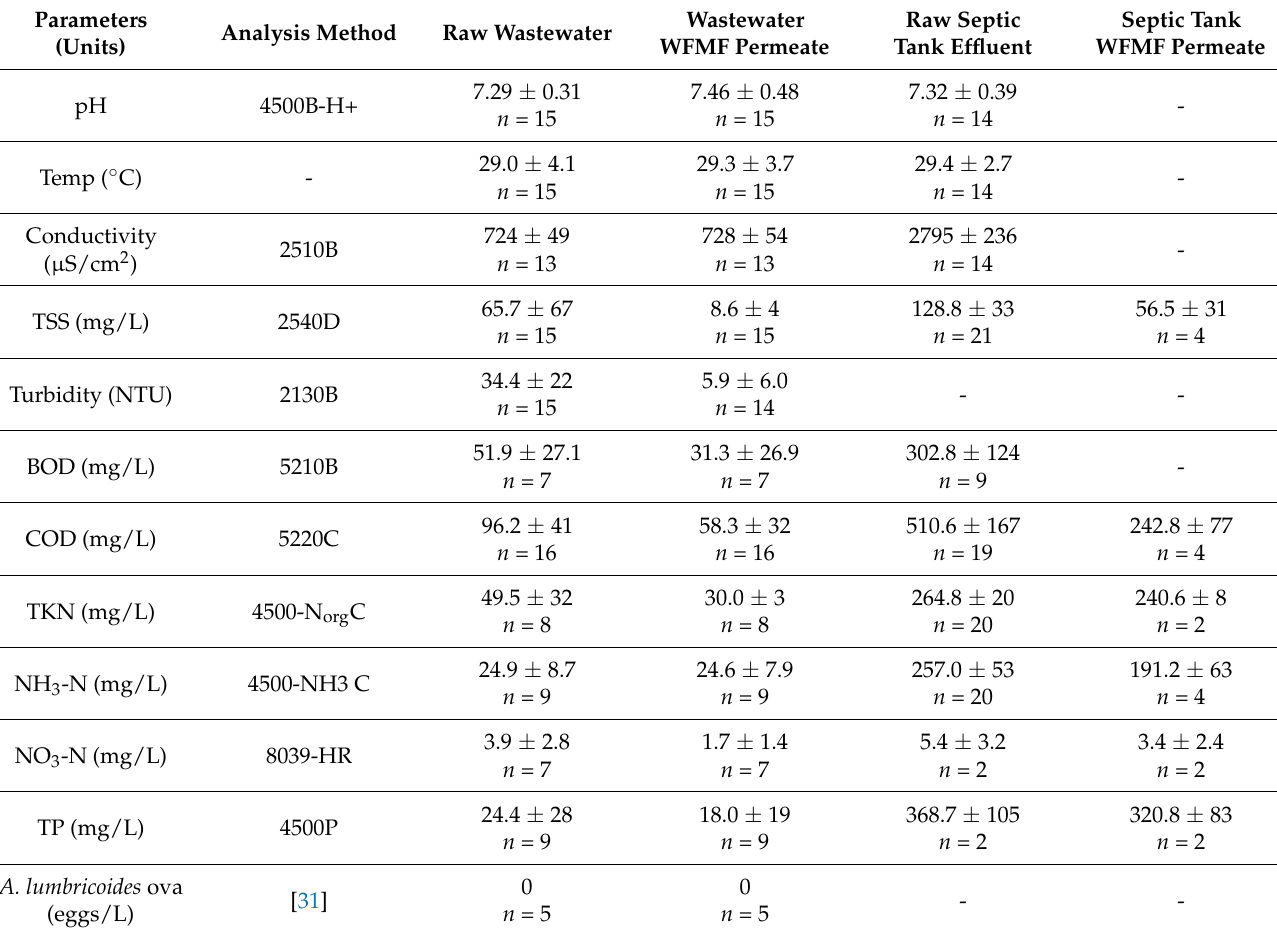
Table 1. Characteristics of AIT wastewater and conventional septic tank effluent before (raw) and after the WFMF pretreatment (permeate). Data presented as average ± SD with sample size n . Parameters marked with a “-” indicate data that was not collected or